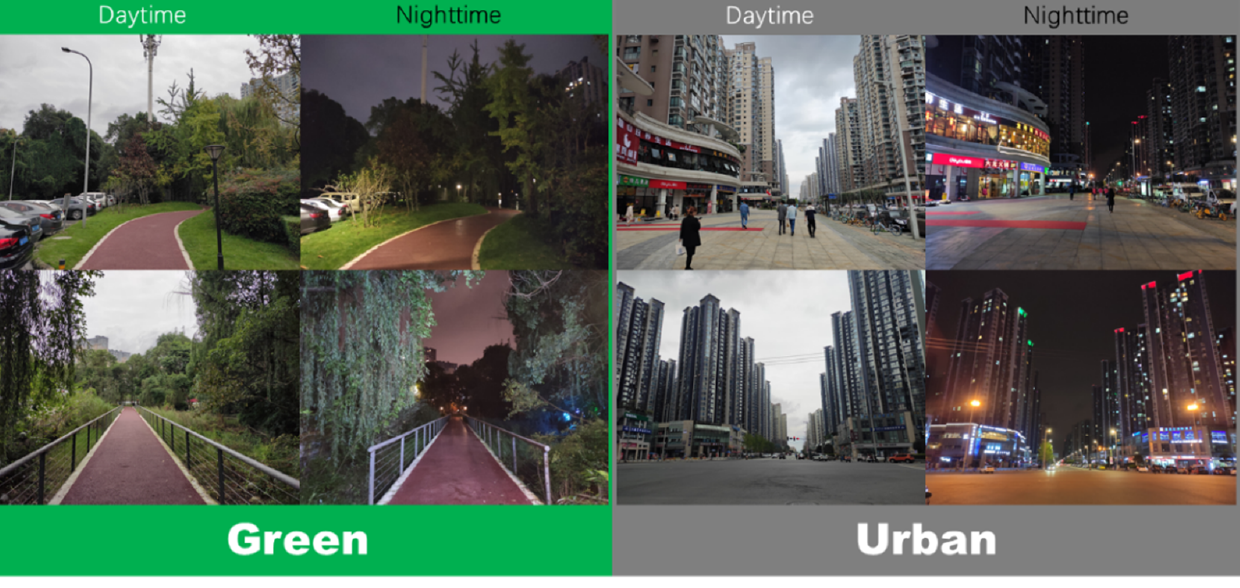
Figure 2. The main views of the two walking routes in daytime and nighttime.